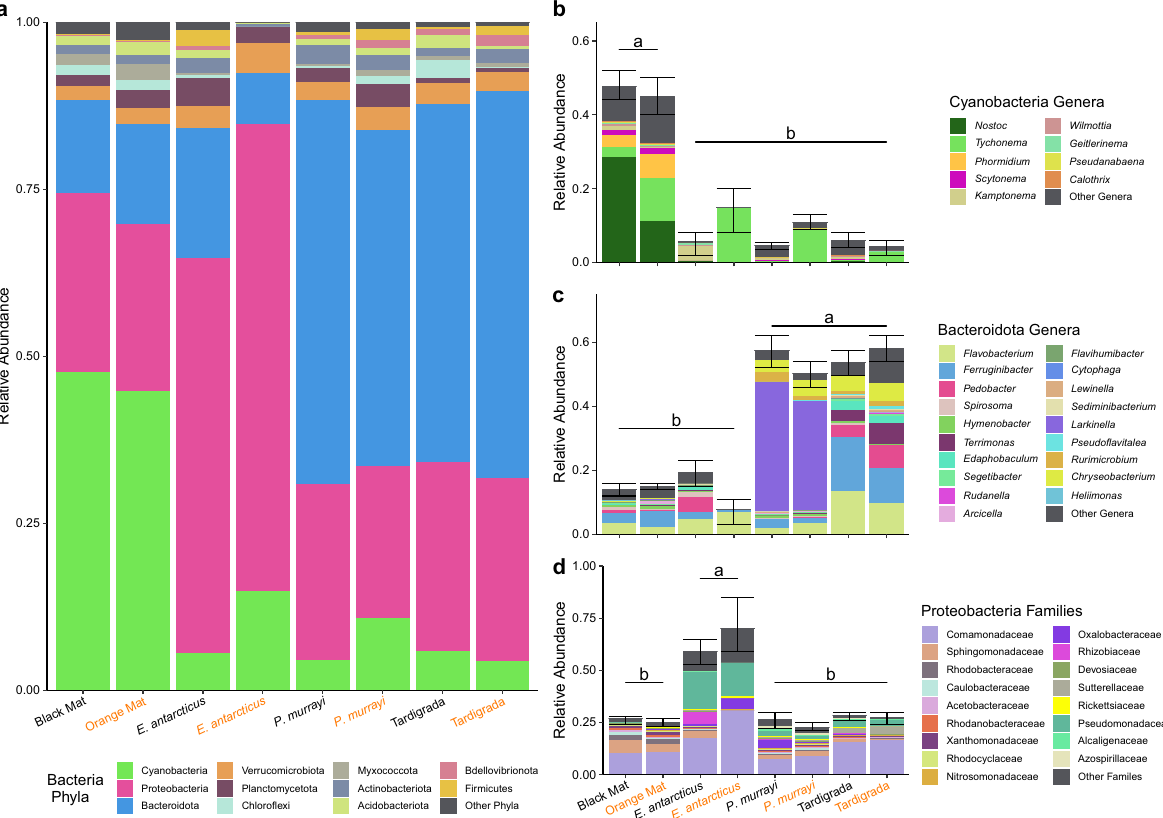
Figure 3. Relative abundance of bacterial communities of mats and microinvertebrate gut microbiomes ( a ) bacterial phyla, ( b ) cyanobacterial genera, ( c ) bacteroidotal genera, and ( d ) proteobacterial families. Horizontal lines and letters indicate statistical differences ( P < 0.05) at the phylum level among the eight communities tested with a GLMM and then Tukey HSD. Error bars represent SE of entire Supplementary Table S5b). In comparison to mats, all microinvertebrate gut microbiomes were significantly depleted of Cyanobacteria (Fig. 3b) and when compared to each other contained similar amounts of Cyanobac- teria. The contribution of cyanobacterial Nostoc declined from an average 19.2% within both mat types to 0.2% within gut microbiomes. Although cyanobacterial Tychonema was an order of magnitude more abundant than Nostoc within gut microbiomes, its relative abundance was more than twice as abundant in all mats (7.5%) than in the guts (3.4%). Compared to mats, gut microbiomes of P. murrayi and Tardigrada , but not of E. antarcticus , were similarly enriched in Bacteroidota (Tukey’s HSD, P < 0.05) (Fig. 3c, Supplementary Table S5a). Although gut microbiomes of both P. murrayi and Tardigrada were characterized by similar relative abundance of Bacteroidota at the phylum level, at the genus level Tardigrada microbiome taxa were similar to the mats but at larger relative abundances. In contrast, gut microbiomes of P. murrayi were distinct from the mats and Tardigrada and significantly enriched by the single genus Larkinella making up 37% of its gut community compared to 0.03% of all other microbiome types (Fig. 3c, Supplementary Table S5b). In contrast to Tardigrada, P. murrayi , and mats that all contained similar proteobacterial communities, gut microbiomes of E. antarcticu s were significantly enriched (Tukey HSD, P < 0.05) by Proteobacteria and that of the family Pseudomonadaceae in particular (Fig. 3d). Other Proteobacteria of interest within E. antarcticu s included taxa in Rickettsiaceae, a family recognized for its intracellular symbi- onts. Wolbachia , a well-known intracellular bacterium was absent from any microbiome. Comamonadaceae, the most abundant family of Proteobacteria across all communities was almost entirely (97.91%) represented by Polaromonas. The linear discriminant analysis effect size algorithm (LEfSe) confirmed and further refined these compo- sitional results. LEfSe identified a total of 49 distinctive taxa at different taxonomic ranks specifically affected by the four community types (i.e., mats, E. antarcticus , P. murrayi , Tardigrada) (LDA effect size = 4, P < 0.05) (Fig. 4), but no distinctive taxa when testing for stream (Canada, Bowles Creek, Delta, Von Guerard) or mat type (black or orange). Cyanobacteria (phylum) and Cyanobacteriia (class) were the two most relevant taxa for the mat communities, while Proteobacteria (phylum) and Gammaproteobacteria (subphylum) were the most relevant for gut communities of E. antarcticus (Fig. 4b). Acidobacteriota and Planctomycetota were two other indicative phyla of E. antarcticus but were lower in effect size score. In contrast, there were no characteristic phylum level taxa of P. murrayi nor Tardigrada gut microbiomes. Instead, the most significant taxa of P. mur- rayi gut microbiomes were Cytophagales (order), Spirosomaceae (family), and Larkinella (genus) (Fig. 4b), all